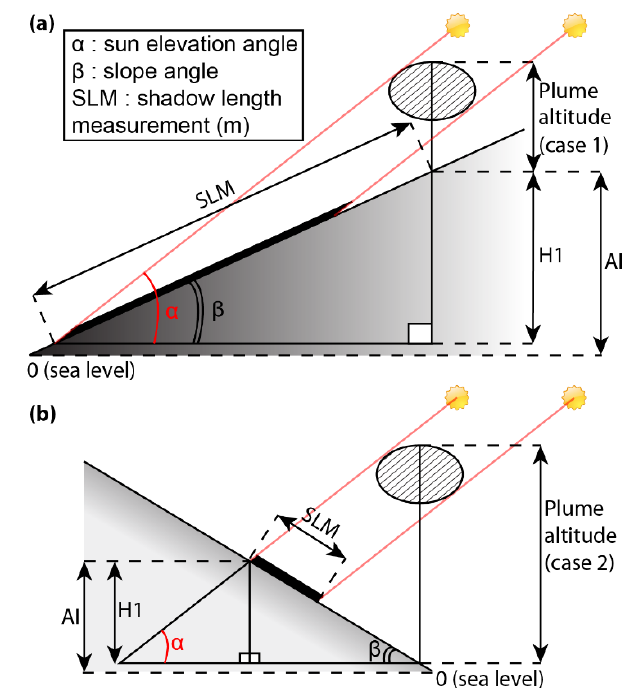
Figure 5. Effect of topography on shadow length measurement. ( a ) Case 1: surface tilted in the same direction as the sunray direction. ( b ) Case 2: surface tilted in the opposite direction to the sun ray direction.